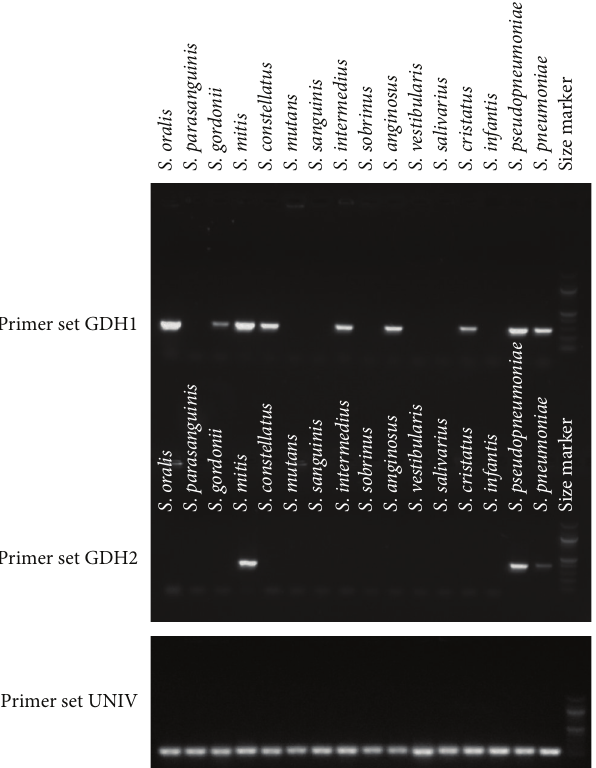
Figure 1: Primer sets GDH1 and GDH2 were evaluated for speci- ficity by testing for amplification of a PCR product from DNA isolated from a panel of ATCC type strains representing species typically found in the oral cavity. Representative gels are shown. The DNA preps used for all primer set amplifications were confirmed to yield product with a set of universal primers (UNIV) for the 16S rRNA